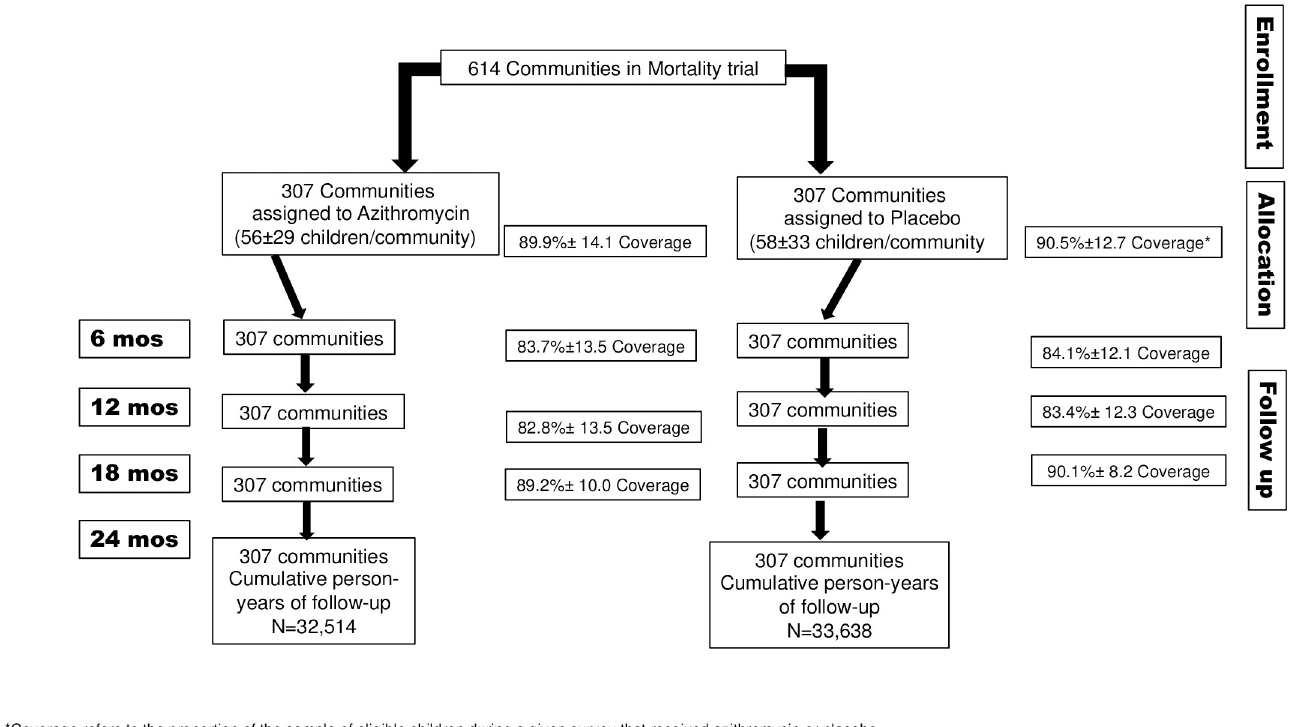
Fig 1. CONSORT diagram: Enrollment, randomization, treatment and follow up of communities in Tanzania.